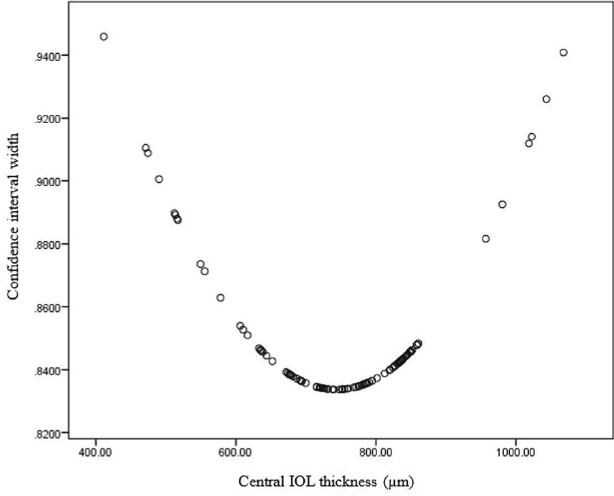
Figure 5. Plot of IOL thickness against confidence Interval (CI) width showing that 95% CI is the narrowest for IOL thicknesses between 600 and 900 microns and becomes wider outside this